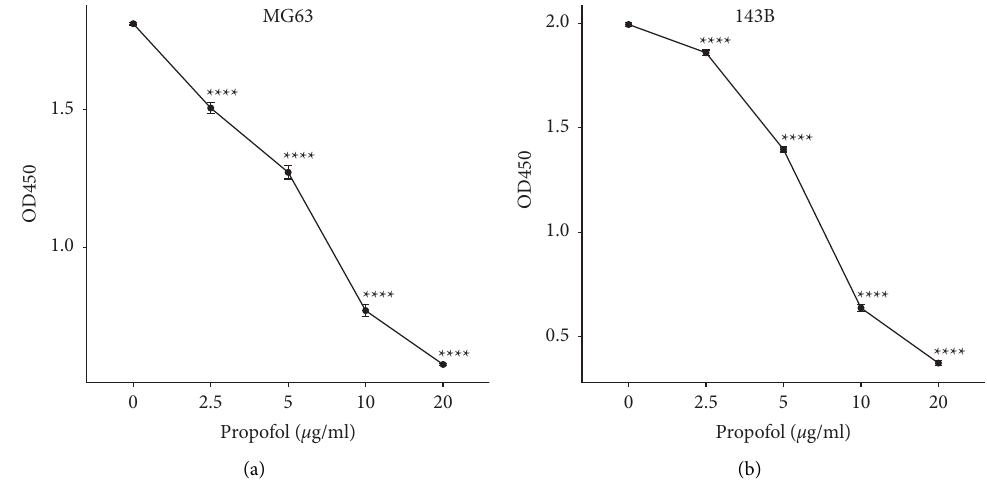
Figure 1: Propofol treatment led to growth inhibition in osteosarcoma. Increasing concentrations of propofol were used to treat the MG63 and 143B cells for 72hours. Growth inhibition was shown in a dose-dependent manner in both (a) MG63 and (b) 143B cells. Each experiment was conducted with 5 biological repeats. ∗∗∗∗ p < 0 .